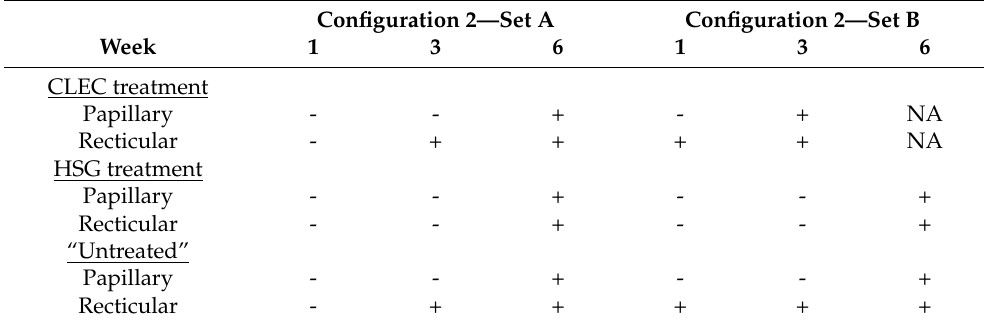
Table 2. Semi-quantitative scoring of Masson’s Trichome (MT) stains at the papillary and recticular dermis of skin tissue biopsies shown in Figure 5a.